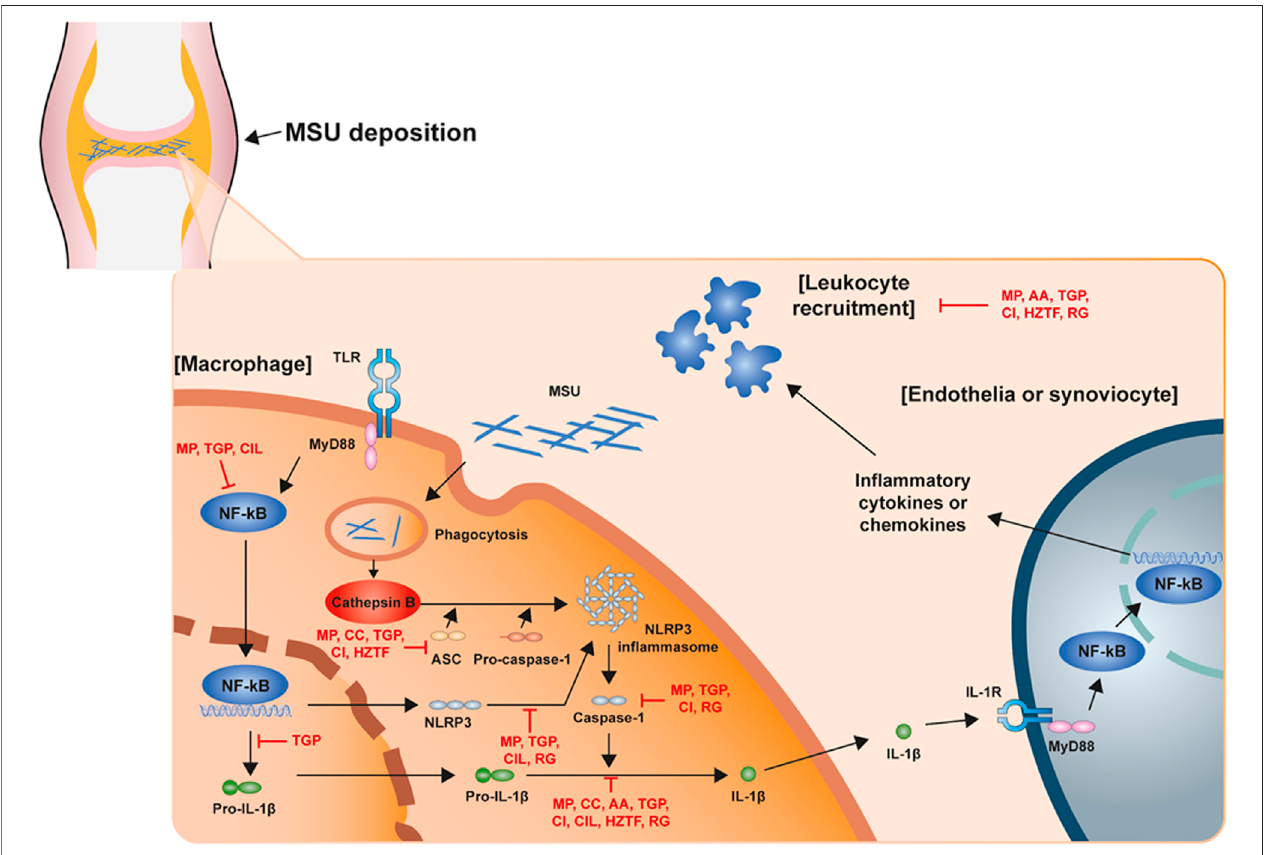
FIGURE 1 | Schematic structure of the acute gout in fl ammation. Mechanism of NLRP3 in fl ammasome activation in acute gout in fl ammation with potential intervention of natural products.